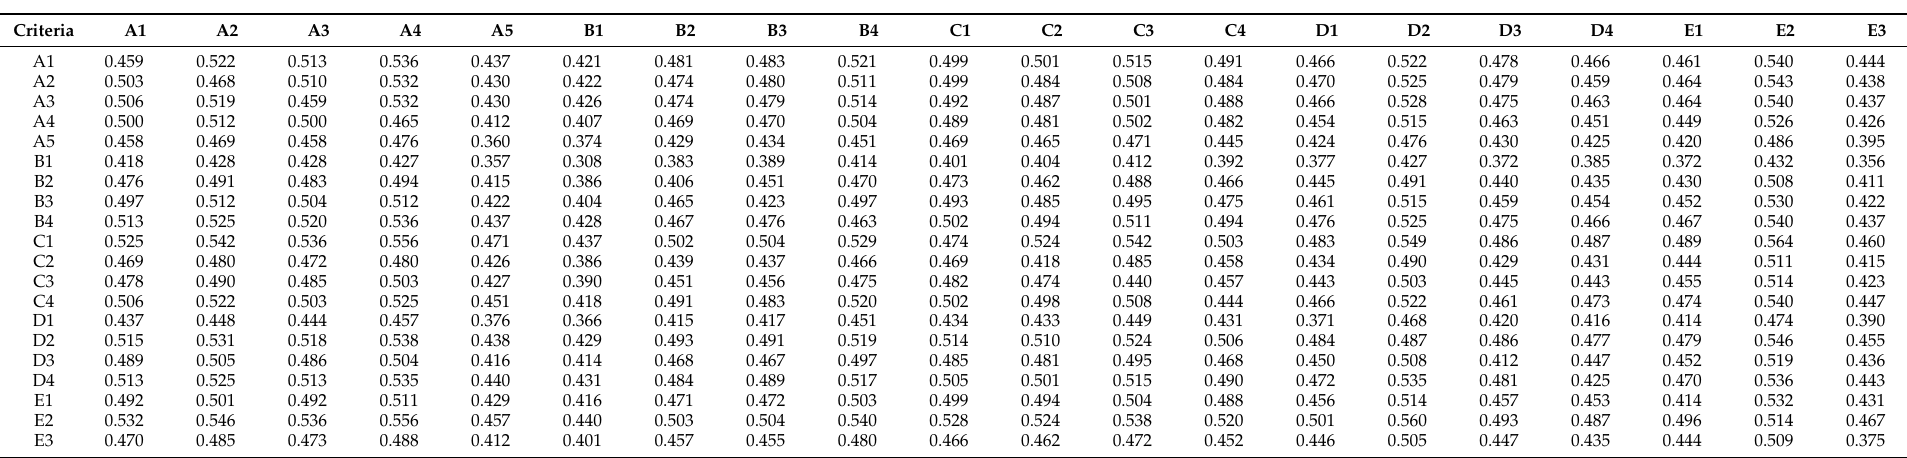
Table A2. Criteria total relationship matrix.